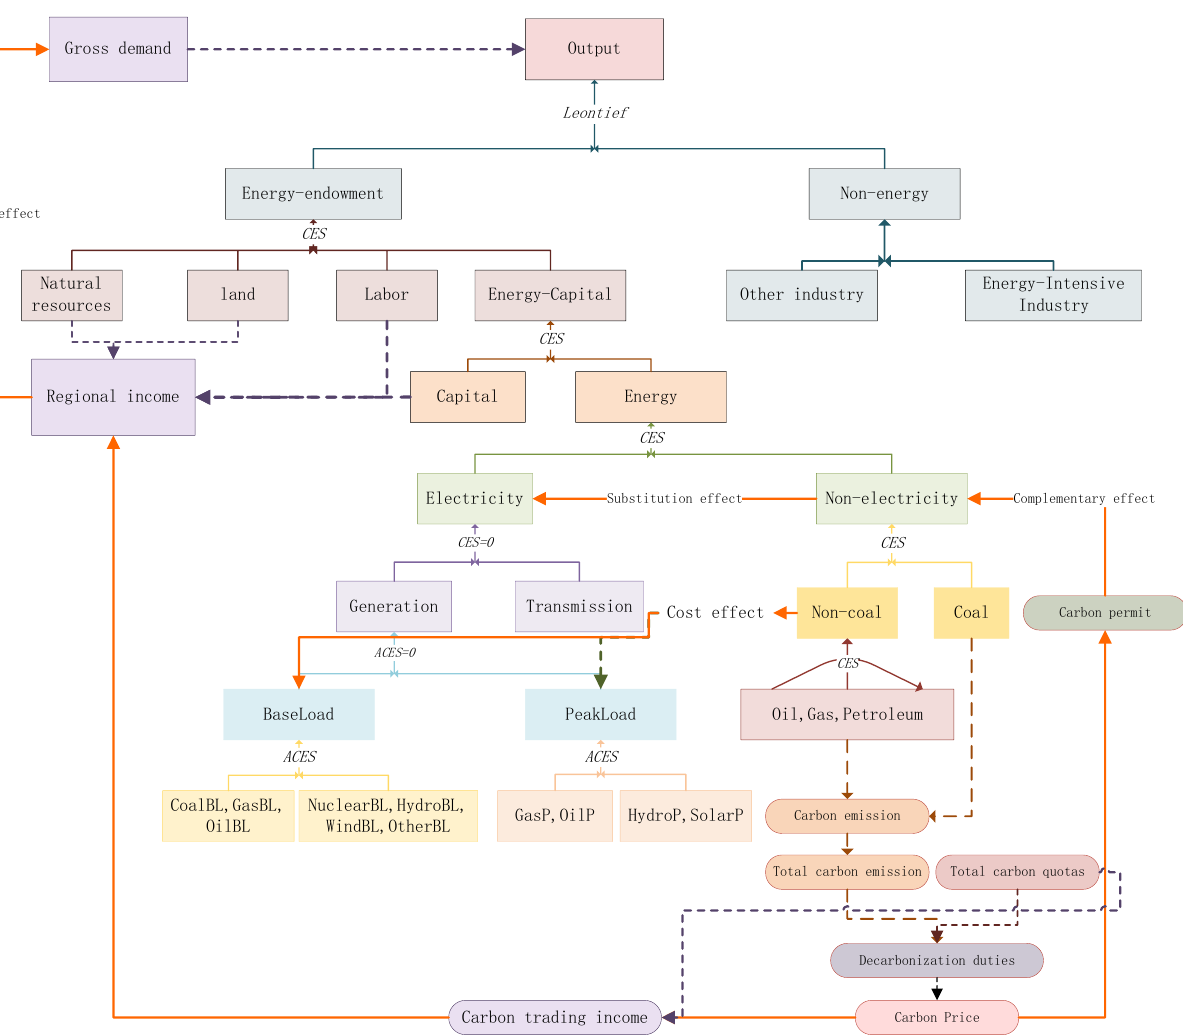
Figure 1. Structure and mechanisms underlying the effect of carbon prices on